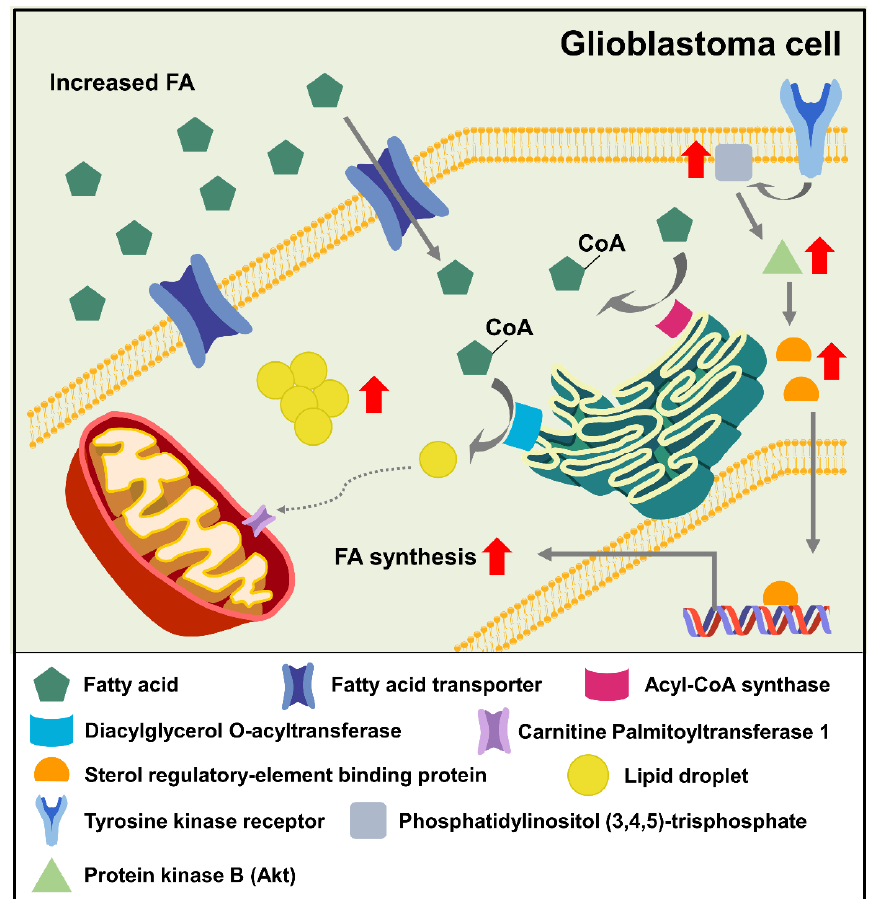
Figure 2. Alteration of FA metabolism in GBM. Fatty acid enters the cytosol through fatty acid trans-